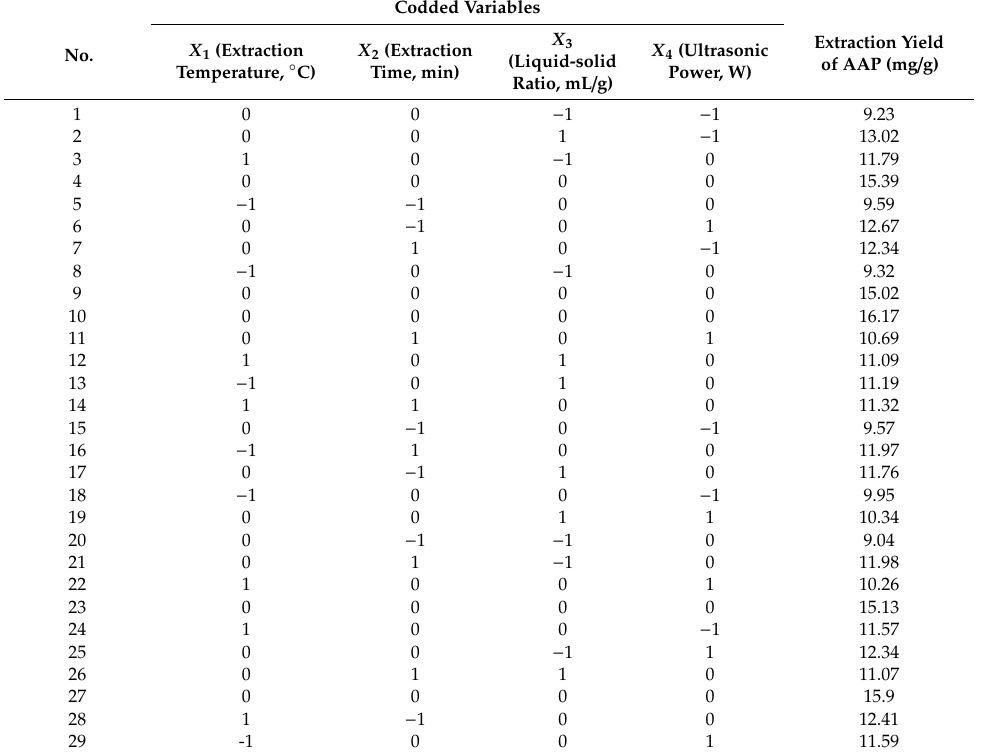
Table 1. Box–Benhnken design and results of AAP extraction experiments.